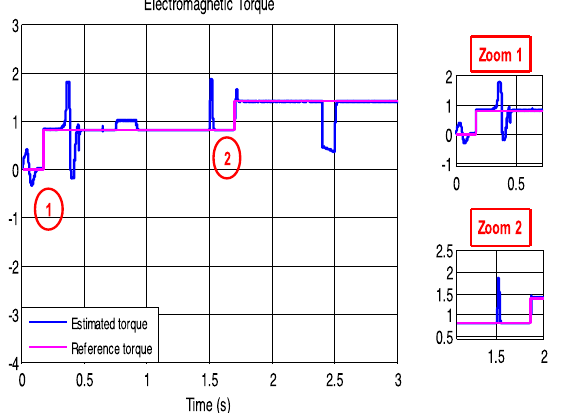
Fig. 22 FL-DTC electromagnetic torque response